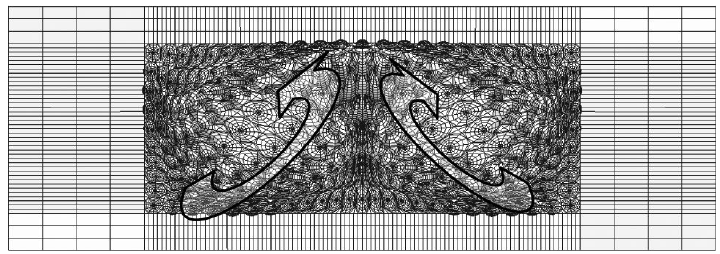
Fig. 44. EIDL 4th mode – 922 Hz – in plane swirl translation.